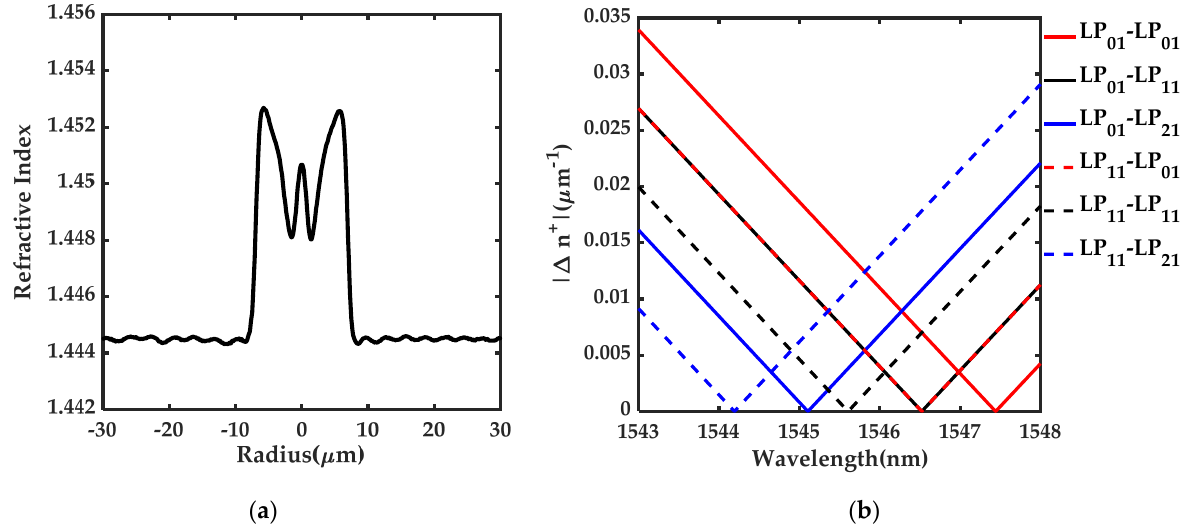
Figure 1. ( a ) The refractive index profile of the homemade few-mode fiber (FMF). ( b ) Phase matching expression ∆ n + as a function of